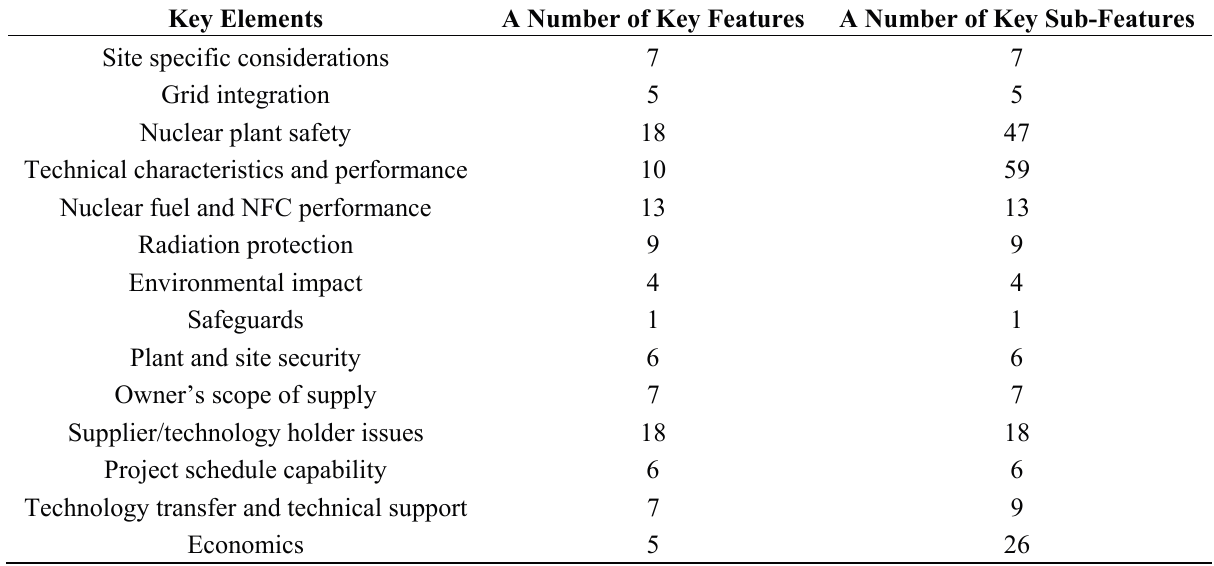
Table 2. RTA key elements, features and